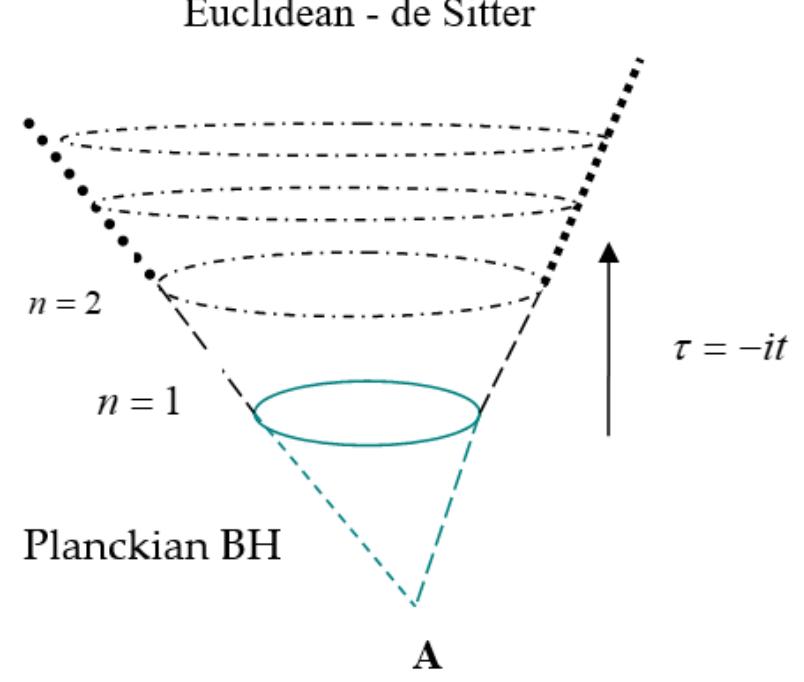
Figure 11. The Planckian BH and the Euclidean de Sitter universe.